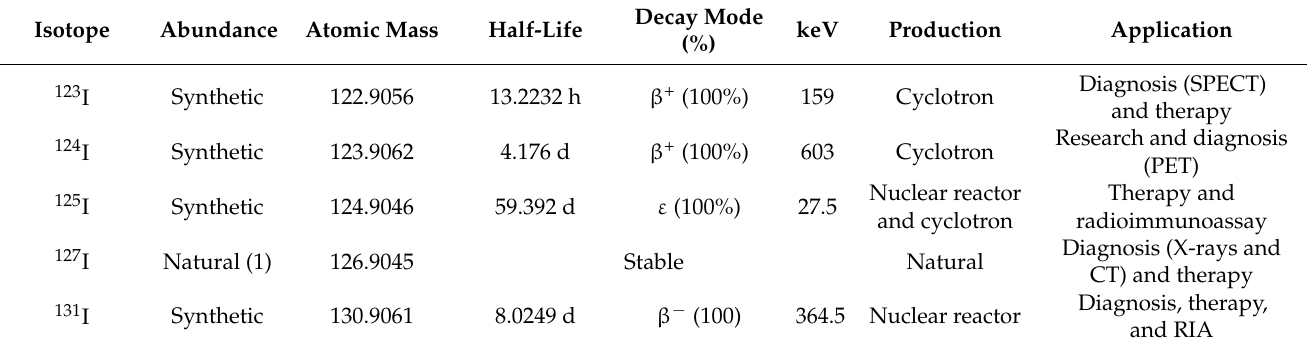
Table 1. Iodine isotopes of relevance in industry and